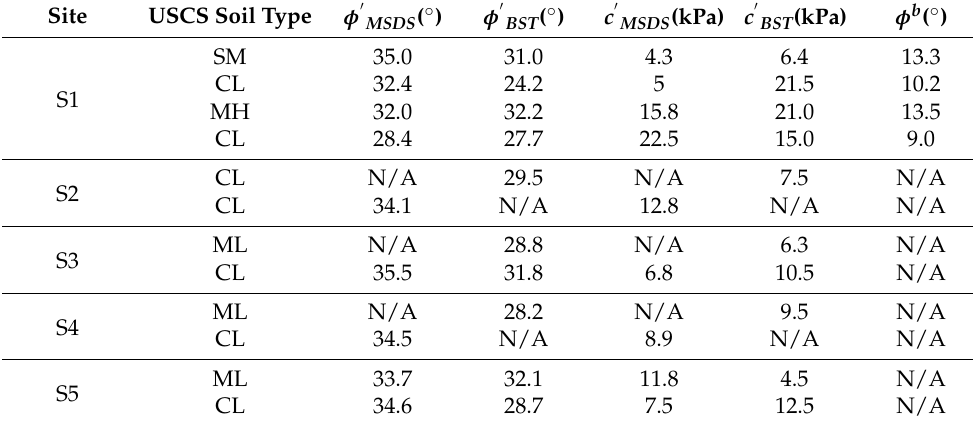
Table 1. Shear strength parameters determined by conventional and suction-controlled MSDS and